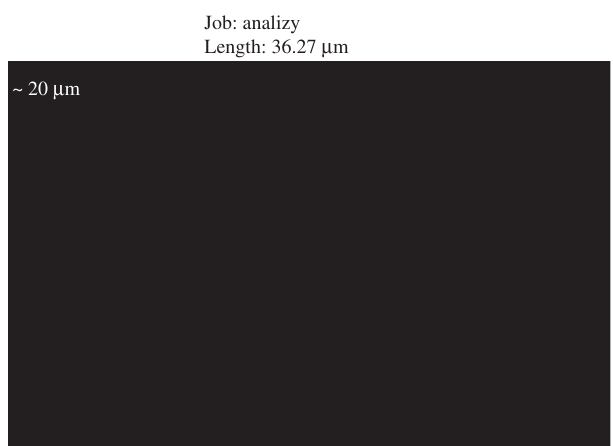
Figure 12. Oxidation in the area of borders, X-ray analysis